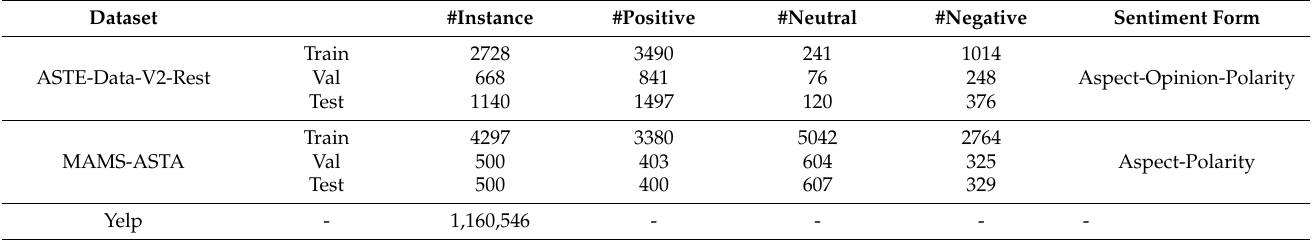
Table 1. Statistics of the labeled and unlabeled datasets. Note that “Val” is short for “Validation”, the ASTE-Data-V2-Rest is labeled with aspect, opinion, and polarity, while the MAMS-ASTA is labeled with only aspect and